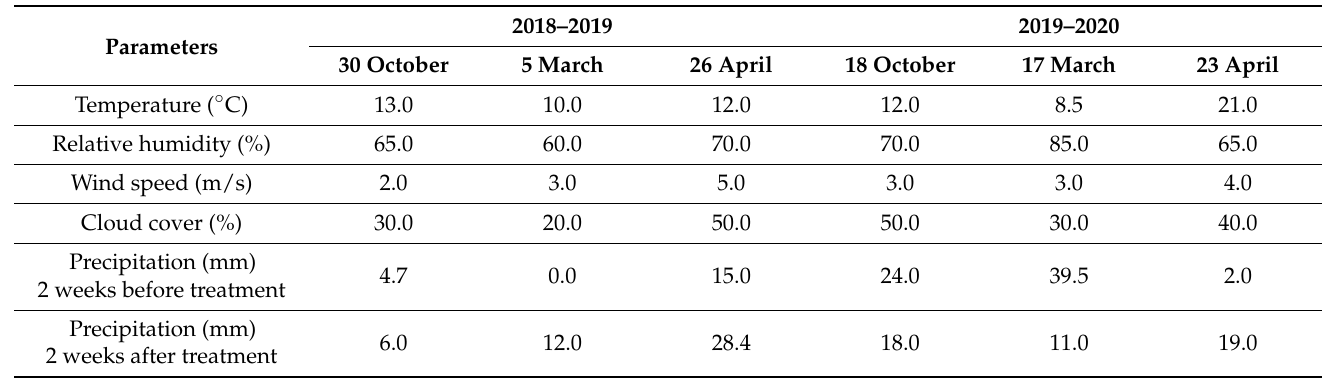
Table 2. Conditions of herbicide treatments in both experiment years 2018/2019 and 2019/2020.